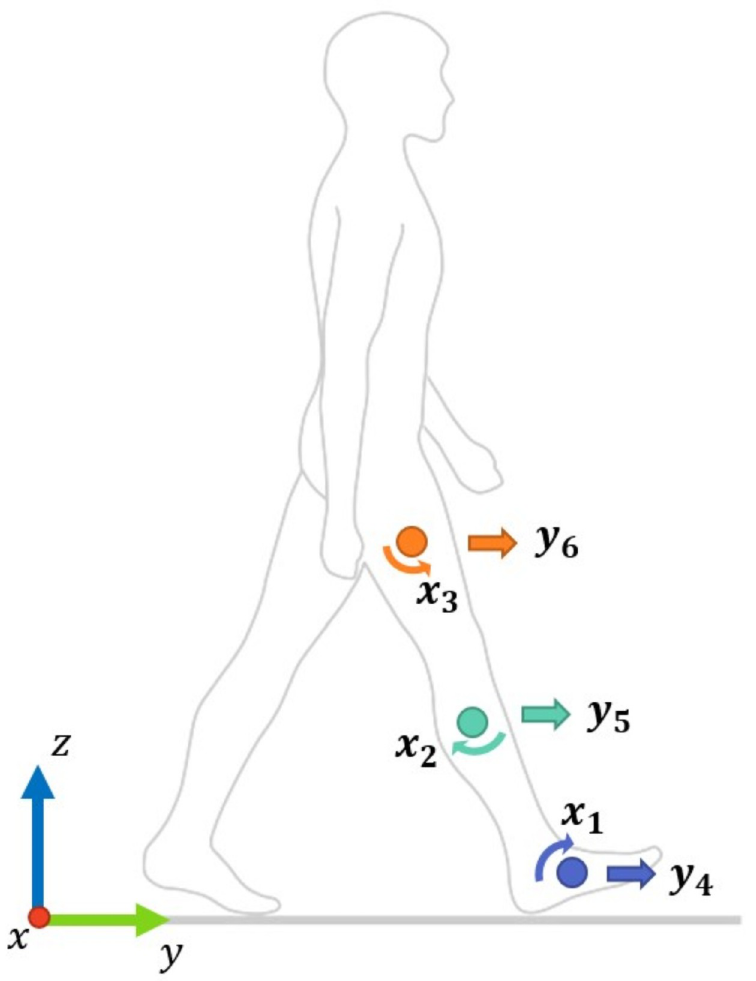
Fig 1. Definition of sagittal plane movements as well as the (X,Y) coordinates. Sagittal plane movements included the rotation around the X-axis (i.e., AV) and the translation along the Y-axis (i.e.,